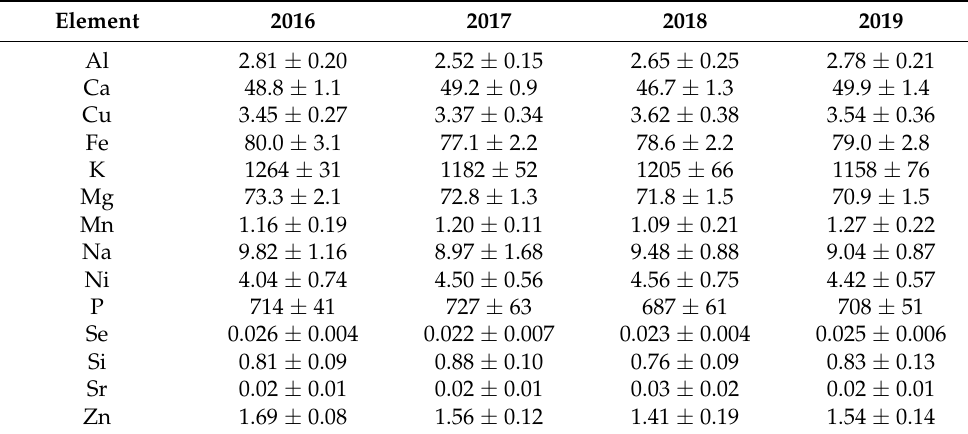
Table 4. Concentrations of some elements (mg/100 g, on dry matter basis) * in horse chestnut flour from AHP semen, harvested in different years.